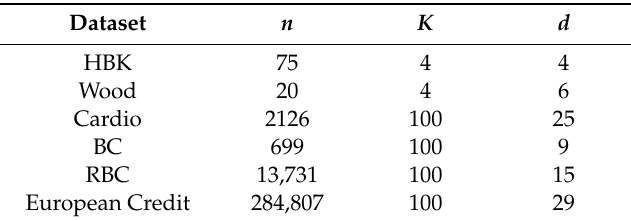
Table 1. Experimental